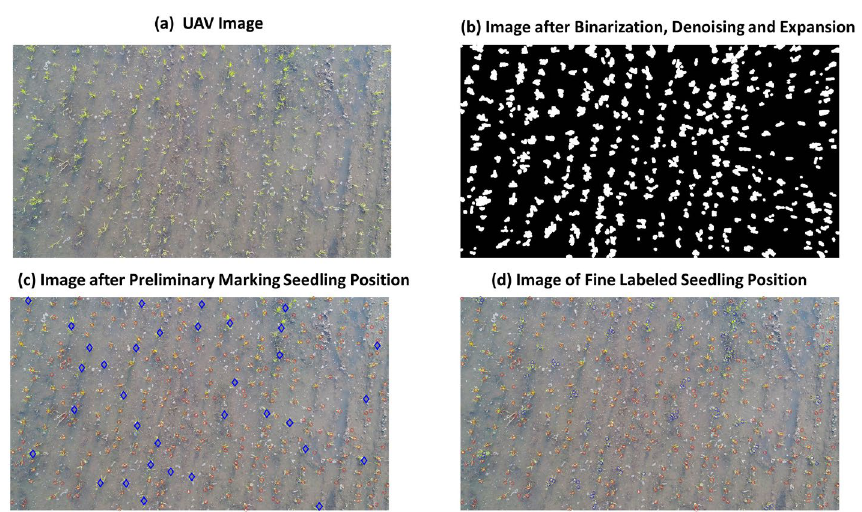
Figure 2. Rice cluster recognition and location labeling process. ( a ): UAV image; ( b ): Image afer binarization, denosing and expansion; ( c ): Image afer preliminary marking seedling positon, the blue diamond indicates the larger component within the > 85th quantile and the red dots indicate the initially labeled seedling positions; ( d ): Image of fine labeled seedling position, the red and blue dots denote the preliminary and detailed labeled seedling positions,